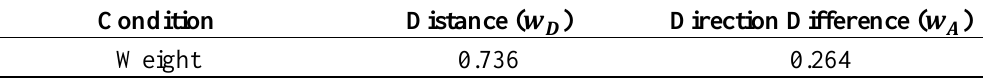
Table 7. Resulted weights evaluated by CRITIC